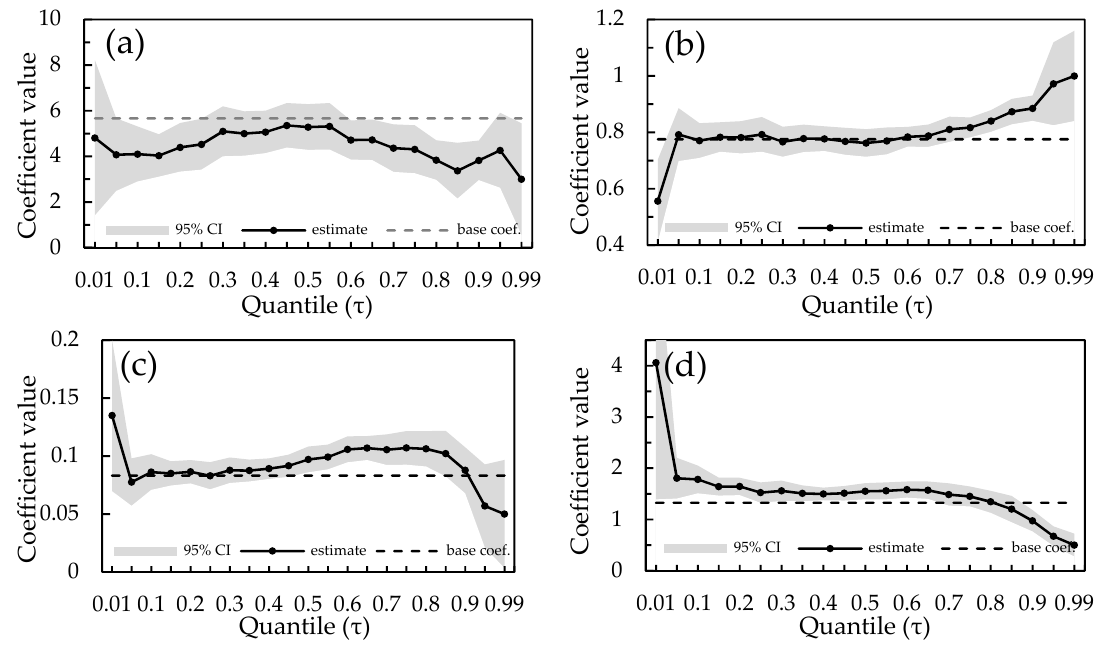
Figure 5. The four coefficient values (a, b, c, d) changing with the quantiles (Figure a – d ). The gray area is 95% confidence interval (CI). The dotted line is the coefficient value of the base model.